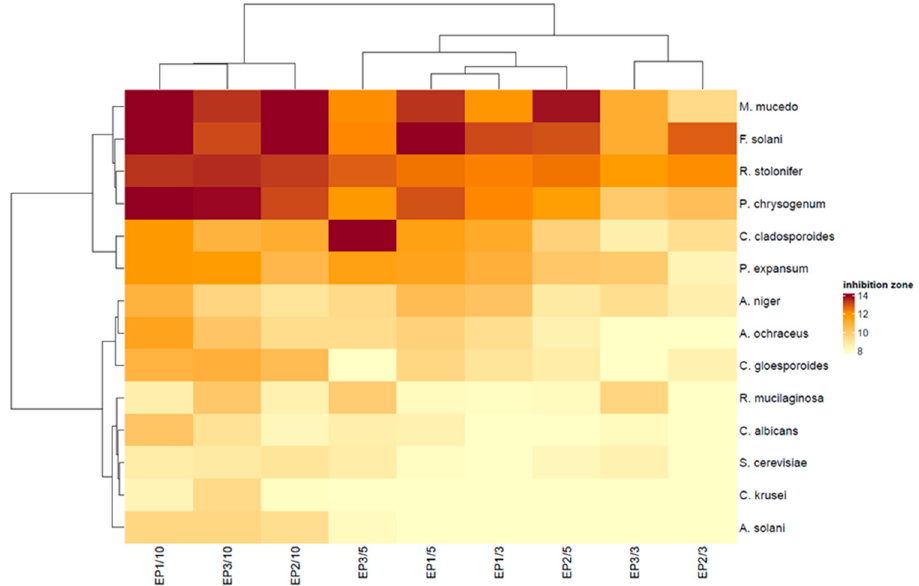
Figure 5. Heat map of antifungal activity of pullulan films with propolis extract (light yellow to dark red corresponding to a progressive increase in the size of the zones of inhibition of growth).